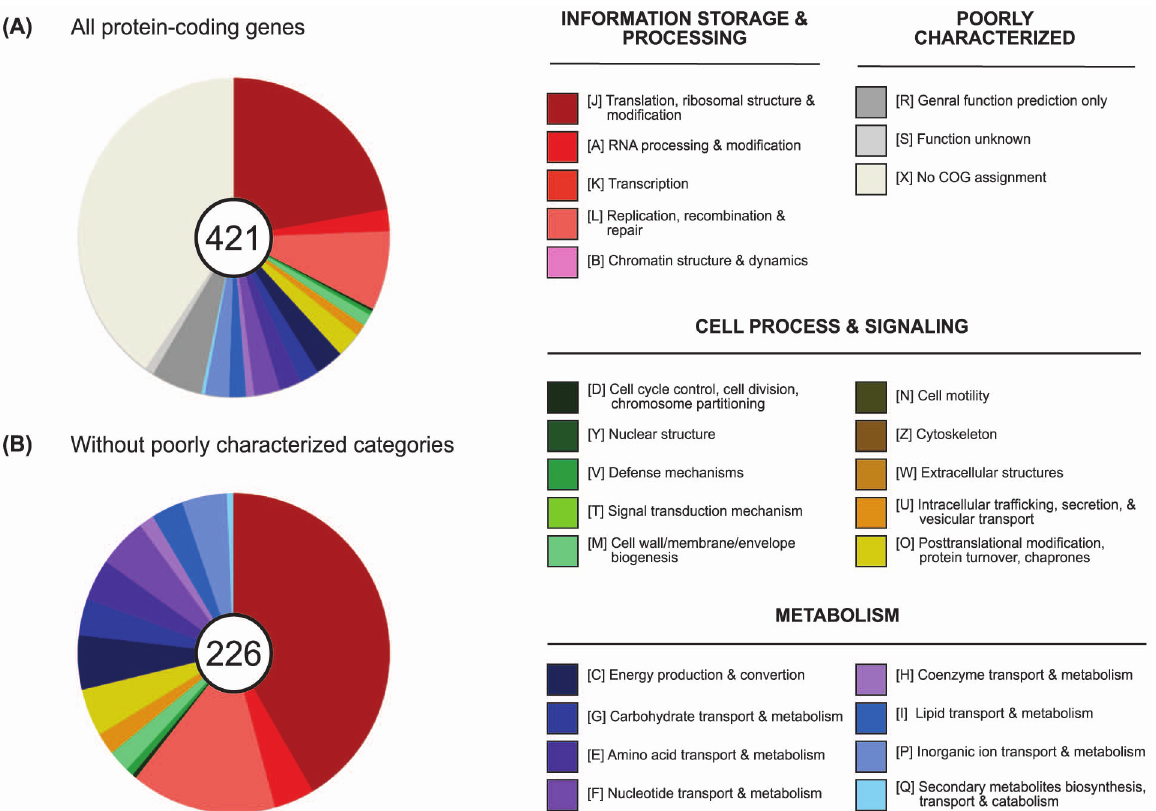
Figure 2. Functional classification of annotated protein-coding genes according to COG assignments. Genes without inferred COG annotation were assigned to a custom category X. The number of protein-coding genes in each set is labeled in the center of each pie chart. (A) All 421 annotated protein-coding genes in the PnWB NTU2011 genome. (B) The 226 protein-coding genes that have specific functional category assignments.